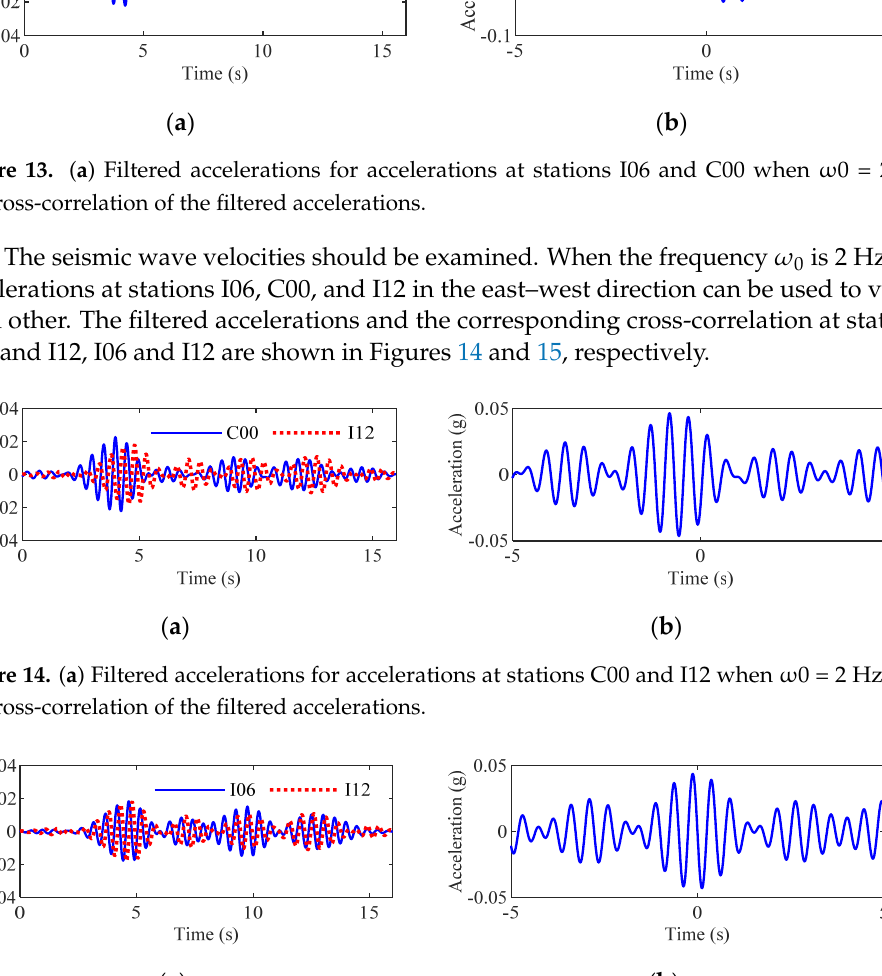
Figure 12. ( a ) Filtered accelerations for accelerations at stations I06 and C00 when ω 0 = 0.8 Hz, and ( b ) cross-correlation of the filtered accelerations.